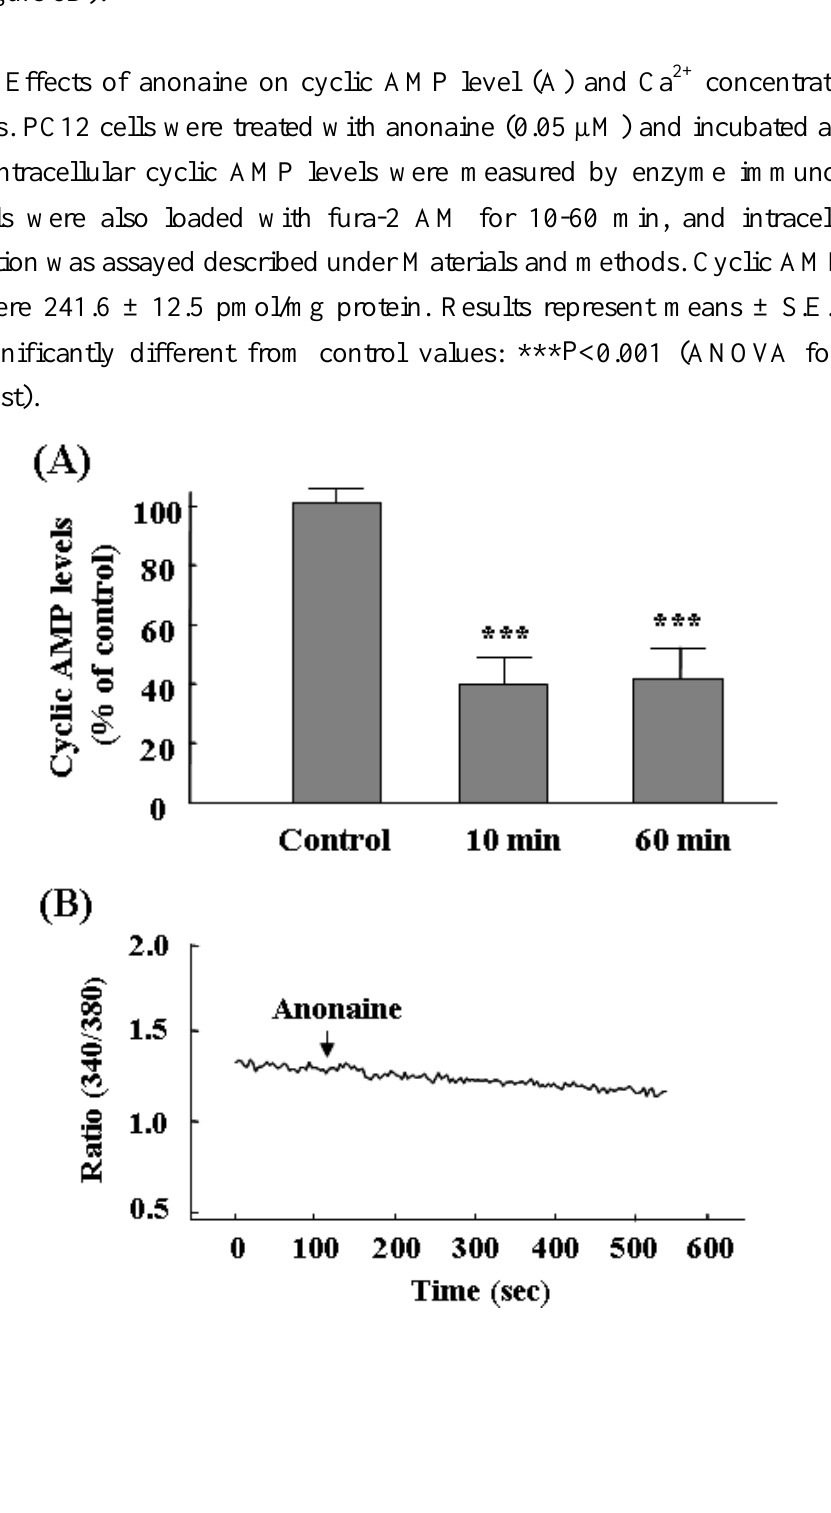
Figure 5 . Effects of anonaine on cyclic AMP level (A) and Ca 2+ concentration (B) in PC12 cells. PC12 cells were treated with anonaine (0.05 µM) and incubated at 37°C for 10 min. Intracellular cyclic AMP levels were measured by enzyme immunoassay